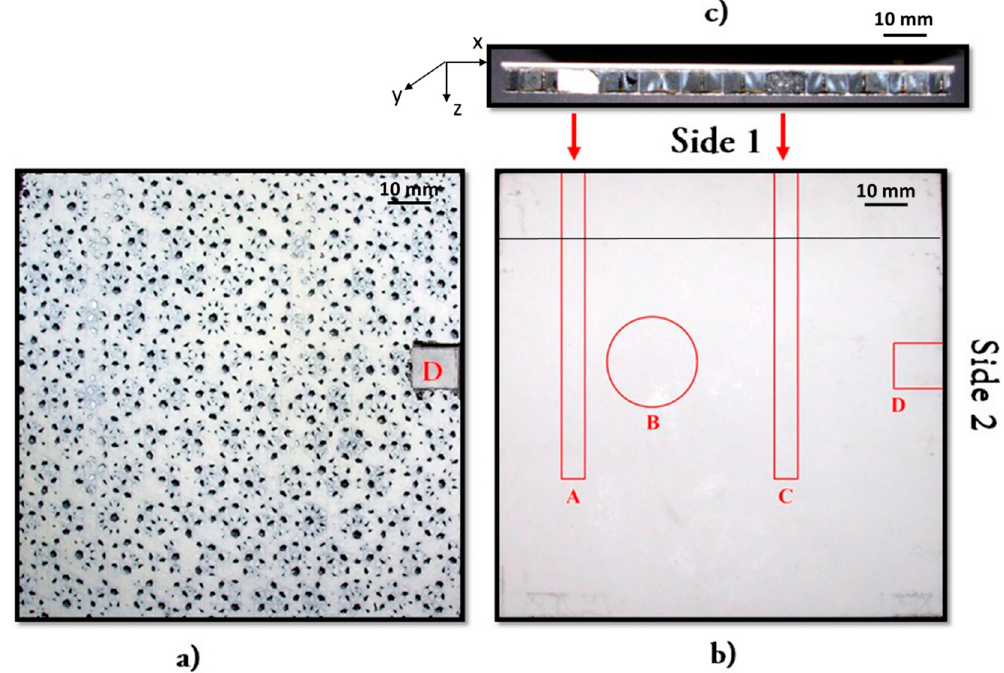
Figure 1. Test sample: ( a ) Rear view showing the sandwich structure; ( b ) Top view showing the alumina ceramic plate, defect B, and fabricated defect D in side 2; and ( c ) lateral view showing cross- section of the fabricated defects A and C (already anticipated in ( b